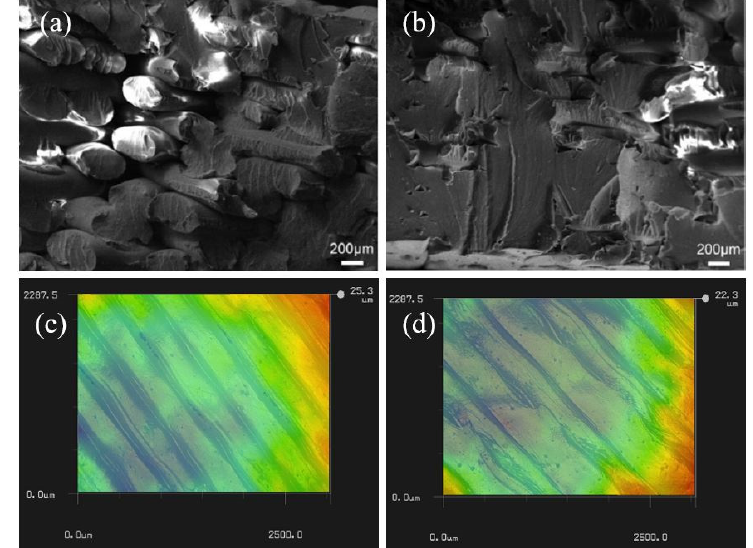
Figure 23. ( a ) Fracture surface of the untreated ABS specimen. ( b ) Fracture surface of the ultrasound treated ABS specimen with improved adhesion. ( c ) Surface morphology of the untreated ABS with visible stripes. ( d ) Surface morphology of the ultrasound treated ABS specimen. ( a ), ( b ): [258], ( c ), ( d ): [257].